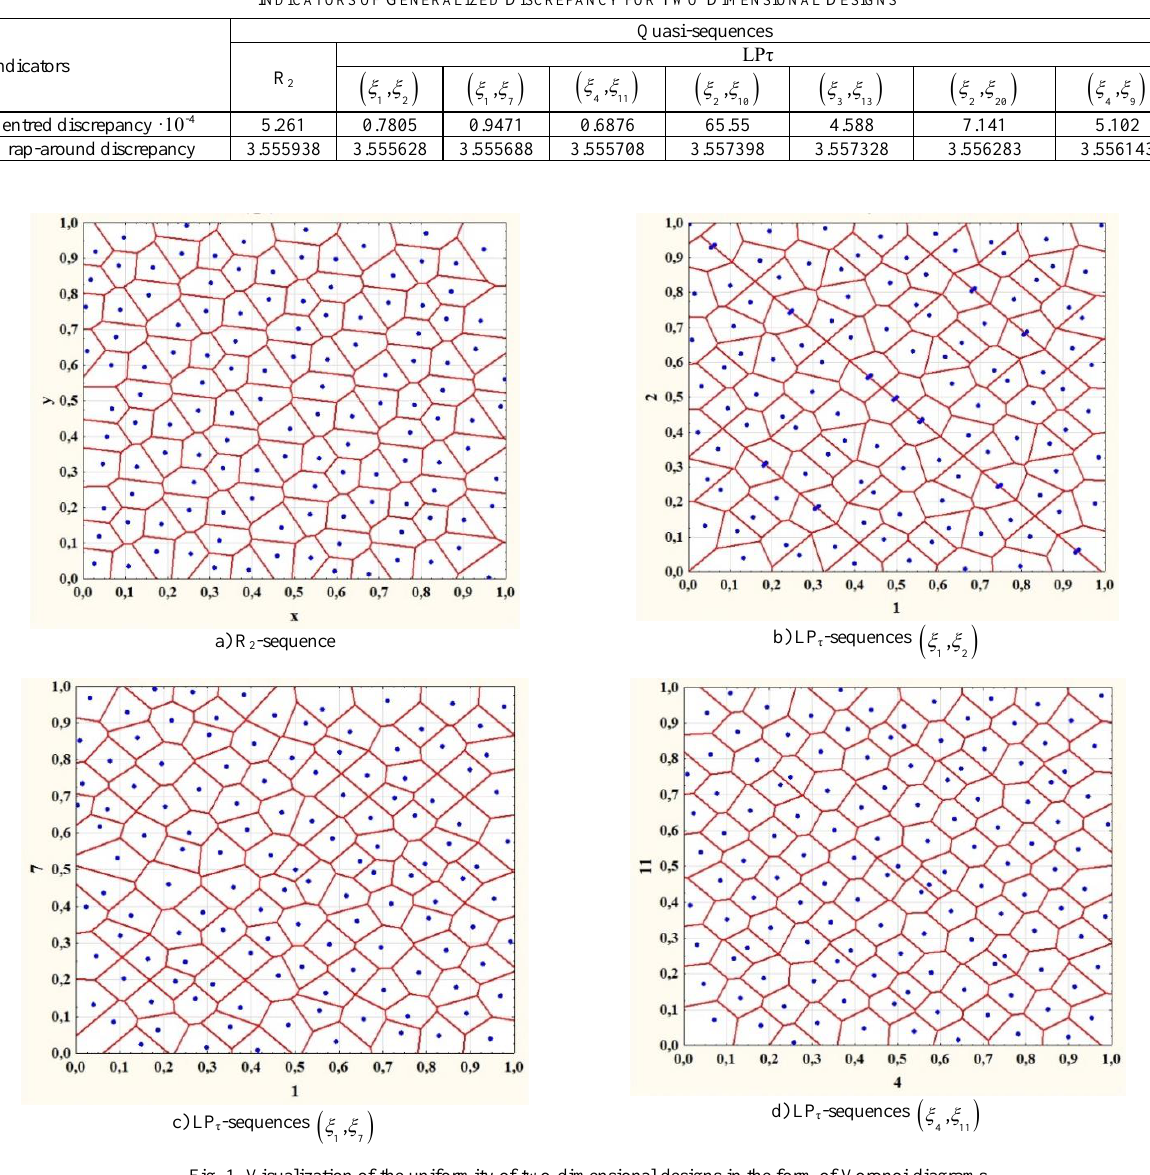
Fig. 1. Visualization of the uniformity of two-dimensional designs in the form of Voronoi